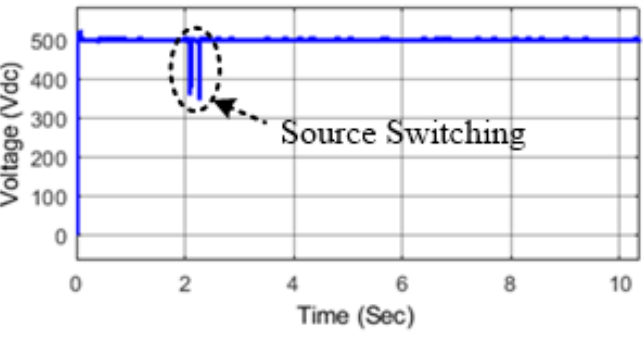
Figure 13. DC link voltage of grid-connected PV system.